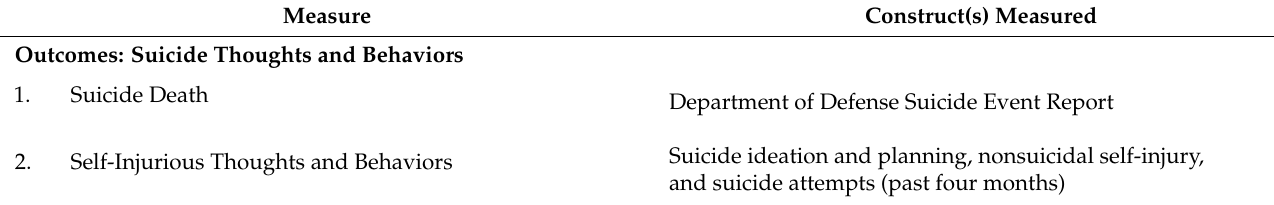
Table 1. Individual variables and constructs